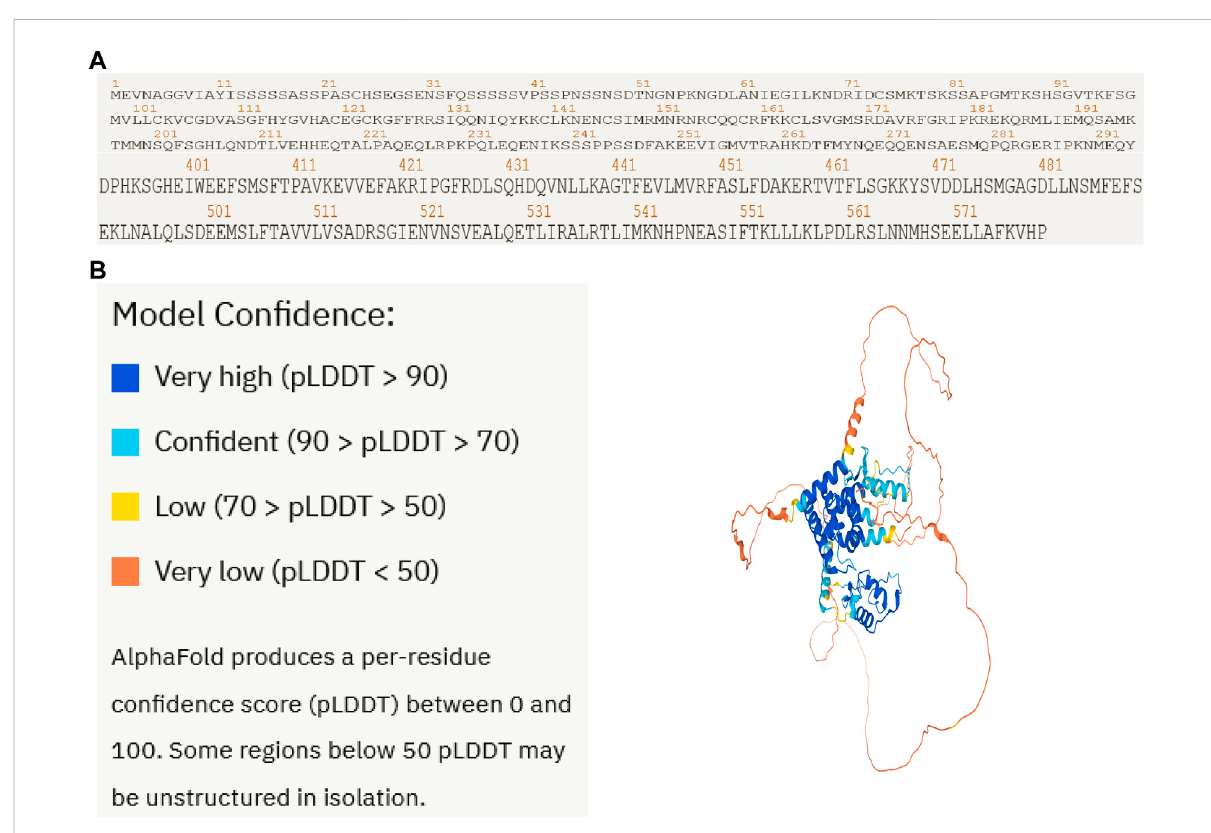
FIGURE 8 Arti fi cial intelligence AlphaFold2 predicts the NR1D2 protein structure. Protein structure ofthe therapeutictarget gene NR1D2 predicted by the AI AlphaFold2. (A) Coding sequence of NR1D2. (B) Protein structure predicted by the AI AlphaFold2.